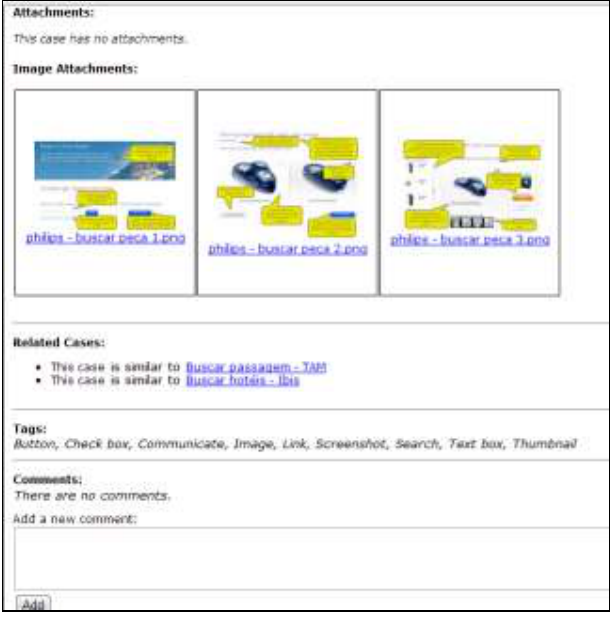
Fig. 5. Case description (attachments, images, relations, tags list and comments),